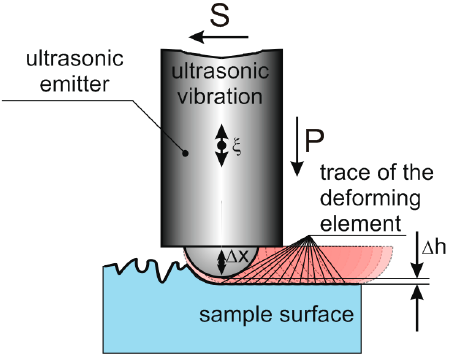
Figure 1. Scheme of treatment by a connected deforming element (S—feed; P—static pressing force; ξ —vibration amplitude of the emitter; Δ x—vibration amplitude of the deforming element ( Δ x = ξ ); Δ h—dent depth of the sample surface).